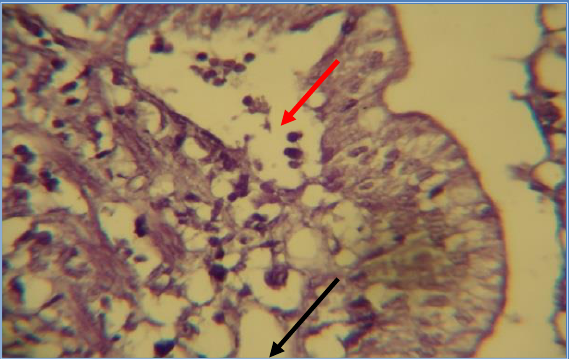
Figure, 8: Histological section in the intestine of 3rd group after 120hrs. heat exposure ( ) shows inflammatory cells infiltration in the subepithelial layer ( ) with vacuolar degeneration of epithelial layer cell. (H and E stain 400X).